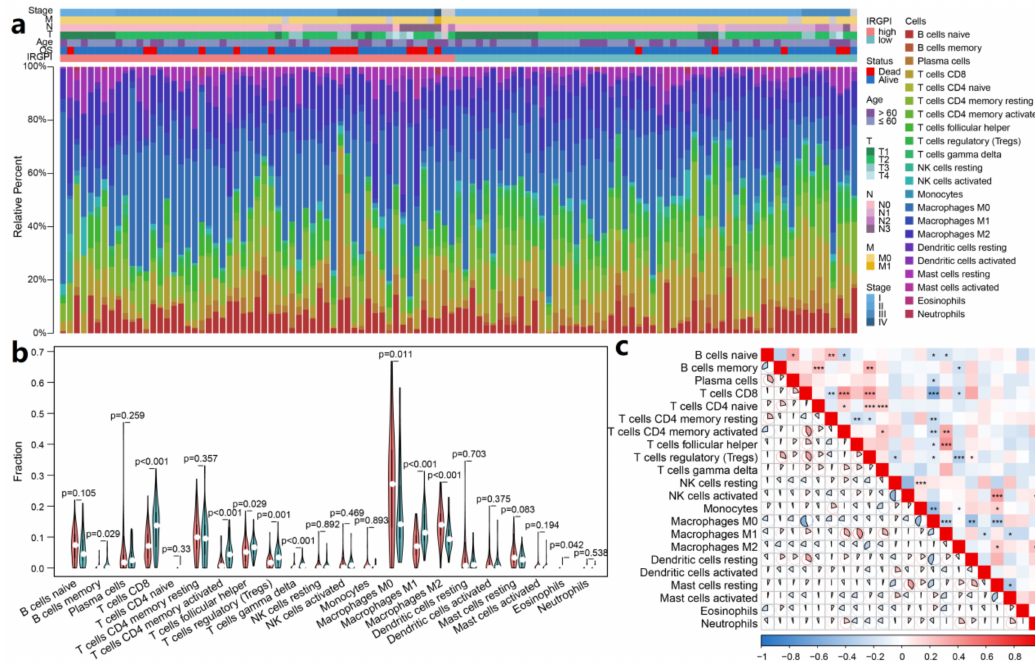
Figure 5. Immune cell compositions in TIME of different IRGPI groups. ( a ) The proportions of 22 tumor infiltrated immune cells of individual patient calculated by CIBERSORT; ( b ) the difference of immune cell infiltration in different IRGPI groups (pink: high IRGPI risk group; and blue: low IRGPI risk group); ( c ) correlations among immune cells in TNBC (ns: not significant, * p < 0.05; ** p < 0.01; *** p <